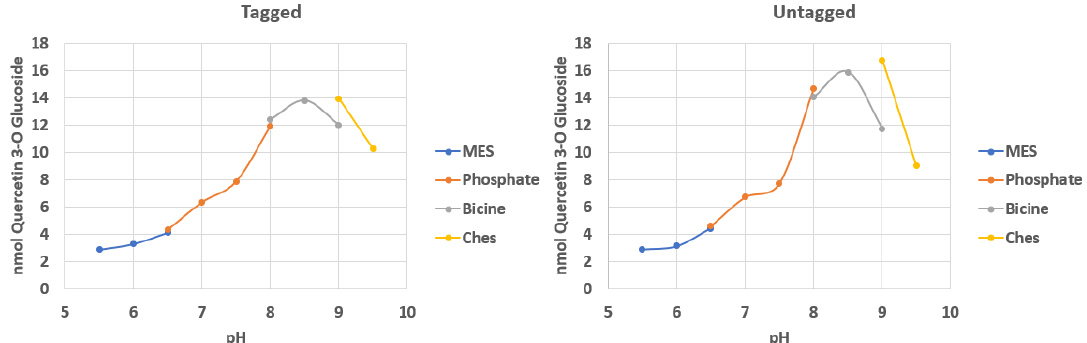
Figure 1. Optimal pH for activity in tagged and untagged Cp3GT from P. pastoris . Formation of